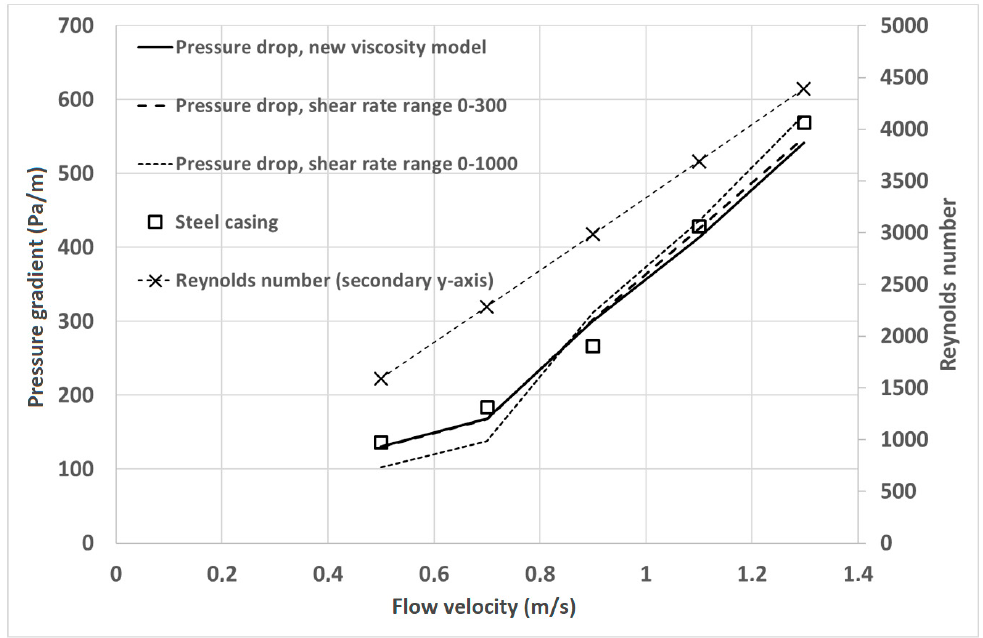
Figure 1. Measured and calculated frictional pressure loss of drilling fluid flow for the drilling fluid presented in Table 1.